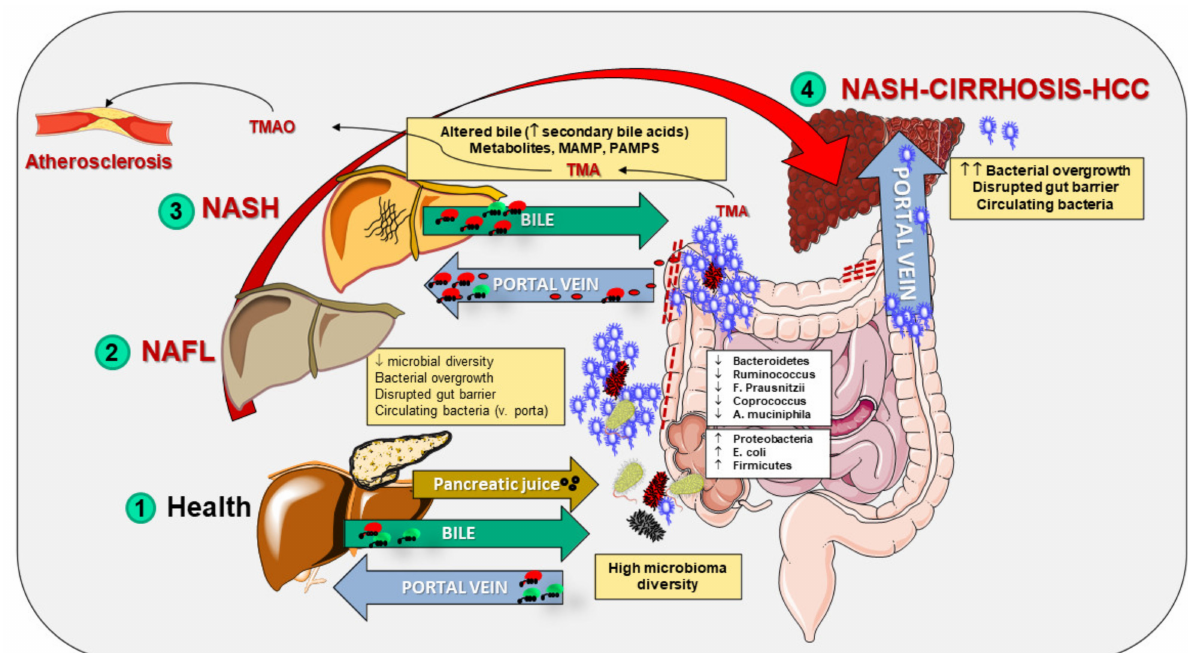
Figure 2. Potential progression of changes in the gut and the liver with ongoing nonalcoholic fatty liver disease. (1) In health, the gut microbiota has high diversity of microbial species to guarantee all physiological tasks. Both bile secretion and pancreatic juice contribute to shaping the gut microbiota. The ratio of primary (green color) to secondary bile acids (red color) is under the control of the healthy gut microbial population (see text for details). (2) With the accumulation of triglycerides, long-chain fatty acids and their metabolites in the liver (simple steatosis, nonalcoholic fatty liver, NAFL), gut microbiota can be reshaped by decreased microbial diversity, small gut overgrowth, disrupted intestinal barrier and circulating bacteria in the portal tract. (3) A further step includes the progressive necro-inflammatory and fibrotic form nonalcoholic steatohepatitis (NASH). This evolution is often associated with the rise in pro-inflammatory and pro-steatotic bacterial products in the portal circuit. Changes of the bile acid pool (a shift to increased cytotoxic secondary bile acids, deoxycholic acid, lithocholic acid by bacterial deconjugation especially in the colon) will increase the delivery of these bile acids via the portal vein to the liver, driving a further damage. The intestinal barrier will further increase the permeability, and mechanisms of damage will be perpetuated. (4) If the sequence NASH-Cirrhosis (and even hepatocellular carcinoma, HCC) develops, the intestinal barrier will be further disrupted and, culturable bacteria can translocate via the portal vein to the systemic circulation. The role of bacterial-gut-derived metabolites with systemic effects is shown with trimethylamine (TMA) produced by bacteria out of dietary compounds, is metabolized in the liver to trimethylamine N-oxide (TMAO) which has pro-atherogenic effects and increases the risk of cardiovascular